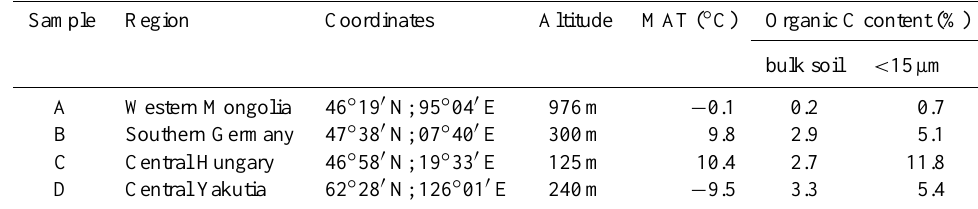
Table 1. Origin of samples (MAT=mean annual temperature) and their carbon content (in %